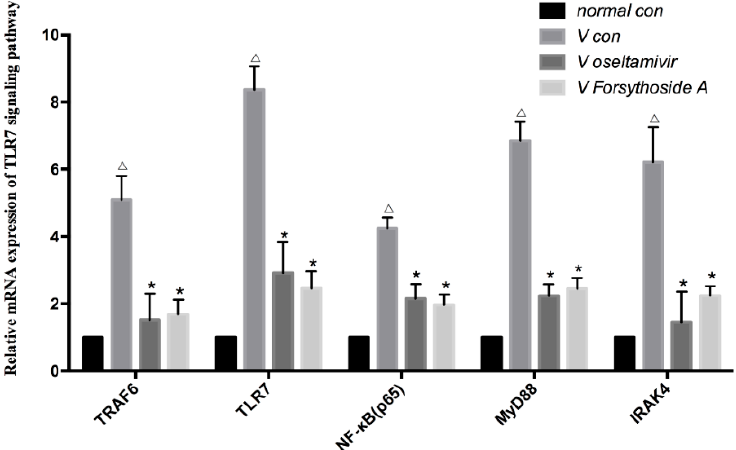
Figure 5. Relative mRNA relative expression of TLR7, MyD88, TRAF6, IRAK4 and NF- κ B (p65) mRNA in the six groups ( n = 12 each). Δ p < 0.01 compared with normal con . * p < 0.01 compared with V con .